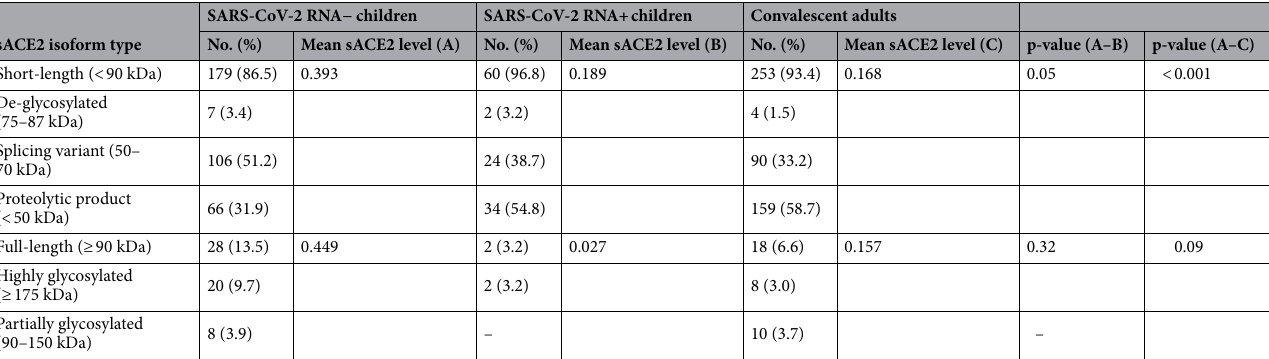
Table 2. Saliva sACE2 isoform identification in children and adults. Mean sACE2 level values expressed as proportions (10 –3 %) of total proteins contained in saliva samples. SARS-CoV-2 acute respiratory syndrome coronavirus 2, sACE2 soluble angiotensin-converting enzyme